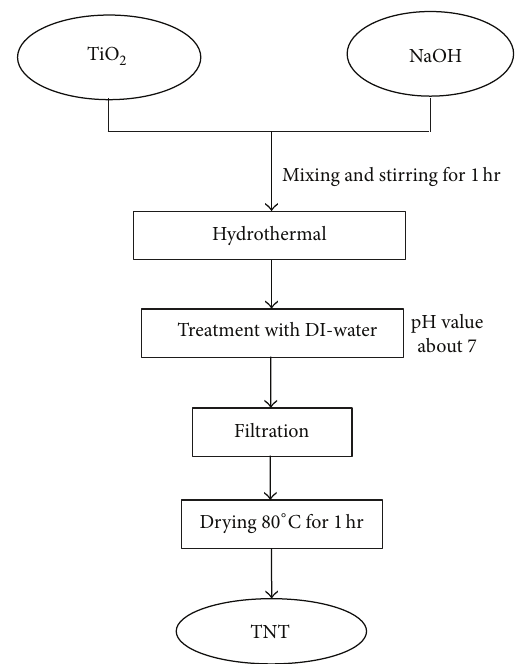
Figure 1: Preparation of titanate nanotubes by the hydrothermal